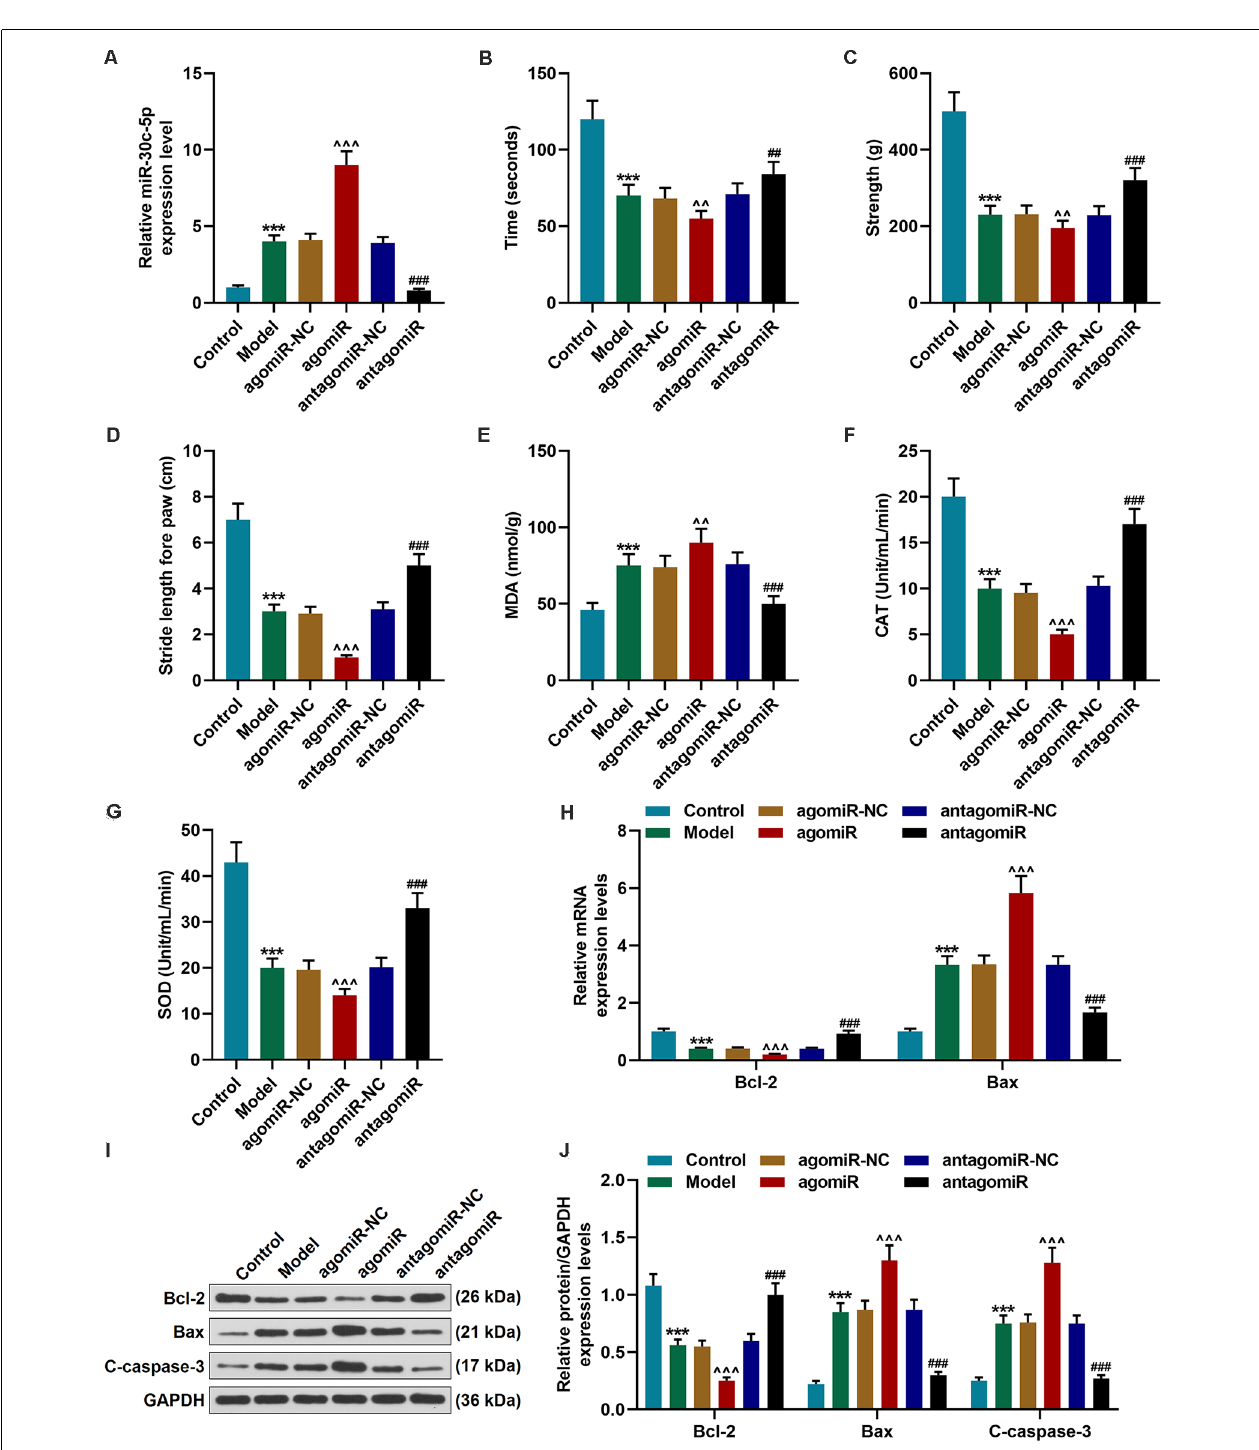
FIGURE 1 | Effect of miR-30c-5p on behavioral symptoms and the levels of oxidative stress-related factors and apoptosis-related proteins in Parkinson’s disease (PD) mice. (A) QPCR analysis of the transfection efficiency of miR-30c-3p agomiR or antagomiR in PD mice brain tissues. U6 snRNA was served as an internal control. (B) The time that the mice stayed on the rotarod was recorded. (C) The grip strength test was used to measure the forelimb grip strength. (D) The locomotor function was assessed using the footprinting test. (E–G) Oxidative stress-related factors malondialdehyde (MDA), catalase (CAT), and SOD were detected in mice. (H) Expressions of Bcl-2 and Bax in brain tissues were determined by qPCR. (I,J) Expressions of Bcl-2, Bax and, cleaved-caspase-3 (C-caspase-3) in brain tissues were assessed by Western blot. GAPDH served as an internal control. *** p < 0.001 vs. control group. ∧∧ p < 0.01, ∧∧∧ p < 0.001 vs. agomiR-NC group. ## p < 0.01, ### p < 0.001 vs. antagomiR-NC